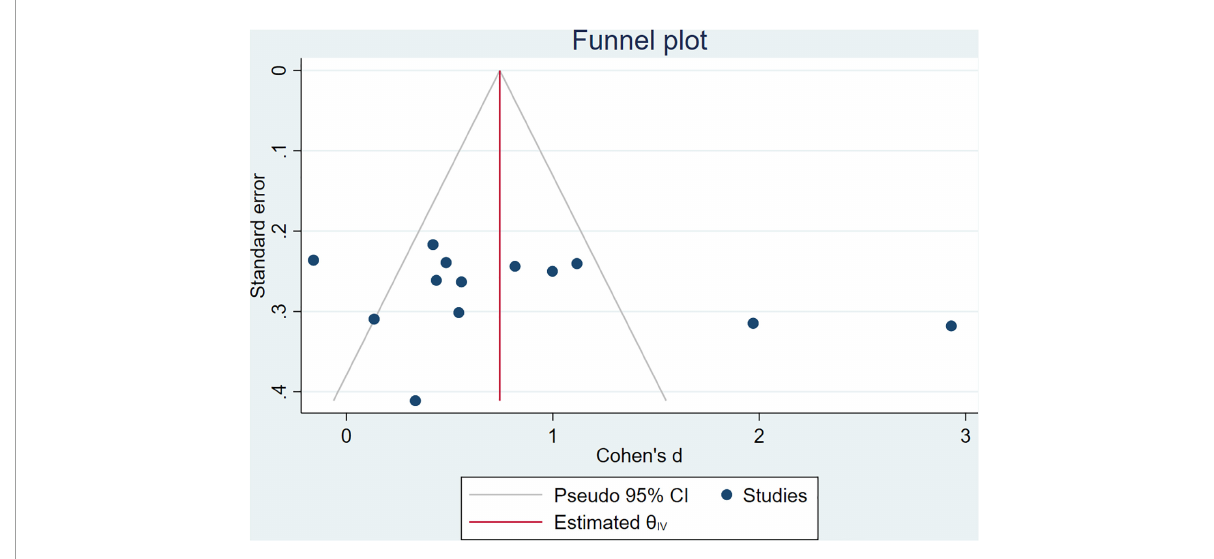
FIGURE4 Funnel plot analysis: publication bias.